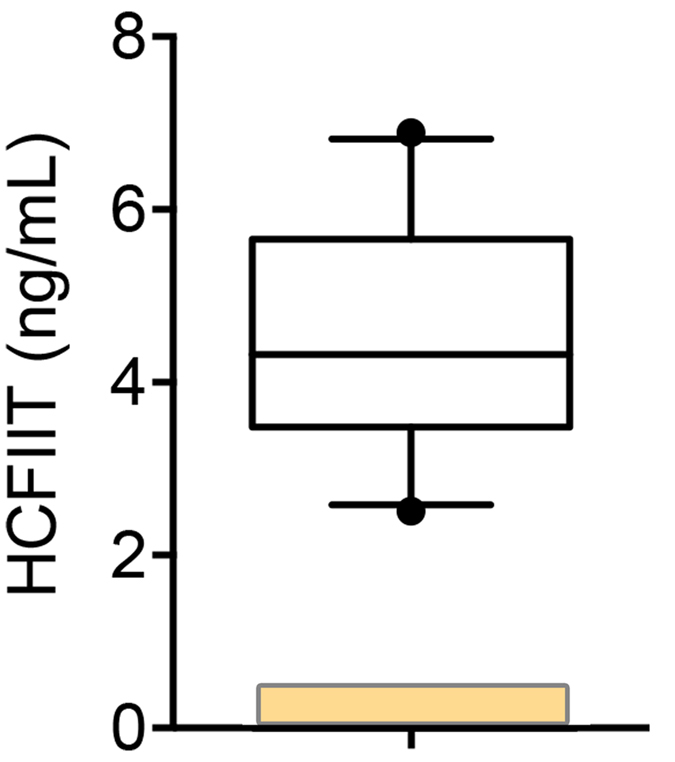
Levels of HCII-T in MPS-IH CSF.The boxes represent to 25th to 75th percentiles with a line at the mean. Whiskers show the 10th and 90th percentiles. Symbols represent value outside the 10 – 90th percentile. The yellow area indicates the non-MPS reference. N = 10 MPS-IH patients. The reference value was determined from the average of four non-MPS samples.